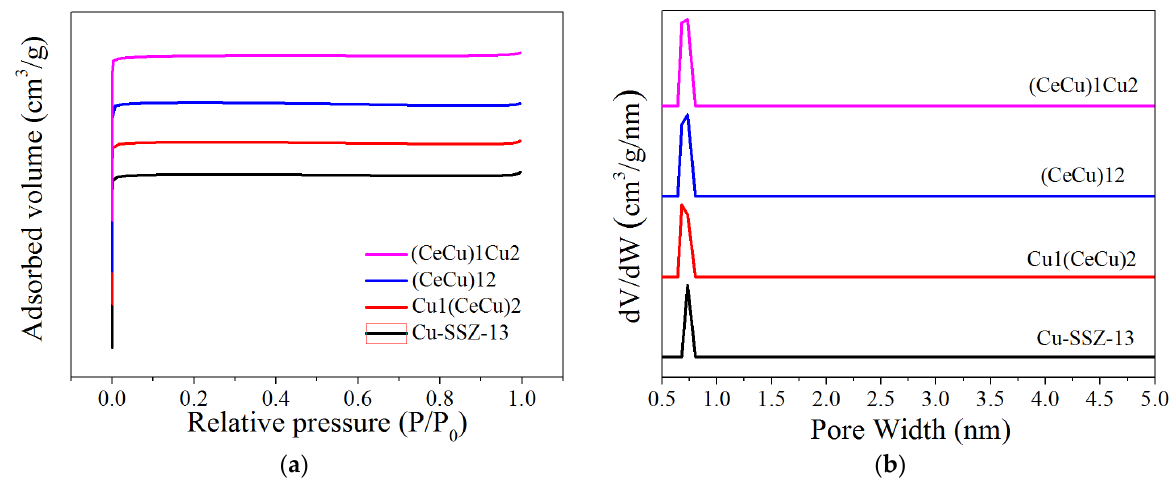
Figure 3. N 2 adsorption-desorption isotherms ( a ) and pore width distribution curves ( b ) of the catalysts.